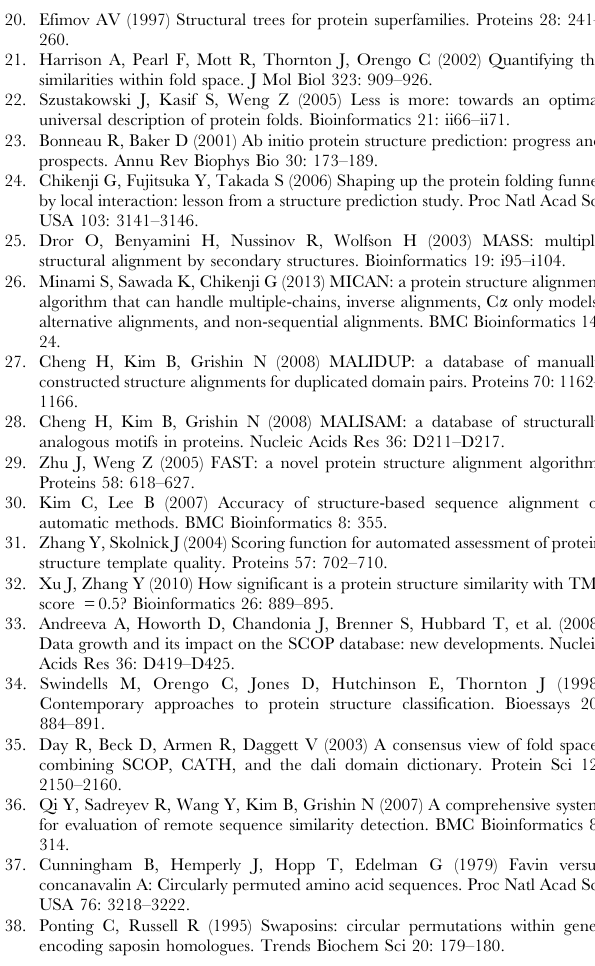
whether two structures are of the same fold, and the threshold for the SQ scheme of MICAN, TMalign, and HHsearch. The horizontal axis represents the threshold and the vertical axis represents the MCC value. As a dataset, we used the SCOP30 set. Figure S4 Graphical representation of the protein fold universe drawn by HHsearch, MICAN SQ, and TMalign. The cutoff value of each method is determined by maximizing the MCC values to decide whether two structures are of the same fold using the SCOP30 set. (EPS) Text S1 Comparison of the SQ network of MICAN with other